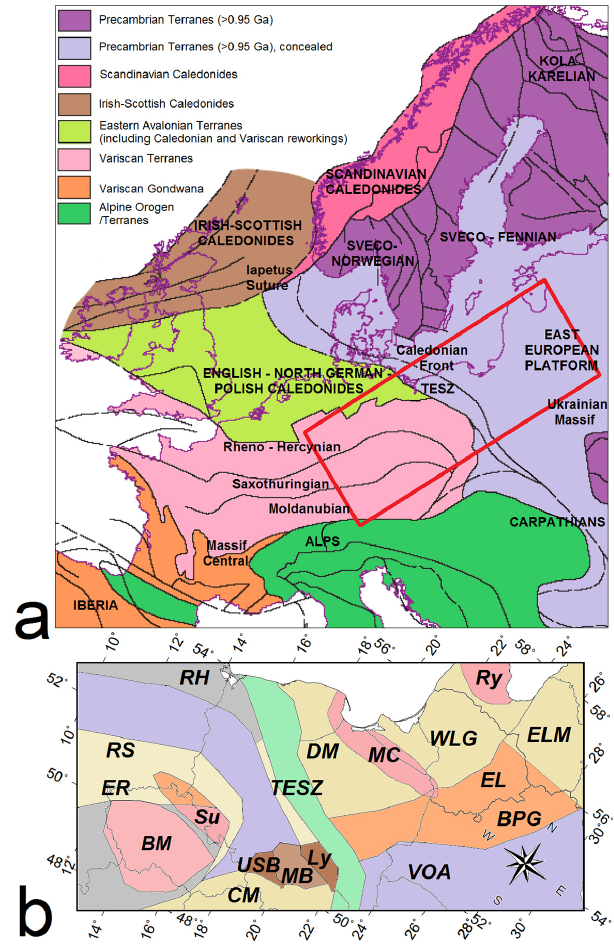
Figure 1. (a) Simplified tectonic sketch of Precambrian and Phanerozoic Europe (after Blundell et al., 1992). Study area indi- cated by red rectangle. (b) Tectonic sketch of the study area com- piled from Skridlaite and Motuza (2001), Malinowski et al. (2008), Guterch et al. (1999), Bogdanova et al. (2001), and Gee and Stephenson (2006). Units: BM, Bohemian Massif; BPG, Belarus– Podlasie Granulite Belt; CM, Carpathian Mountains; DM, Dobrzyn Massif; EL, East Lithuanian Domain; ELM, East Latvian Massif; ER, Eger Rift; Ly, Lysogory; MB, Malopolska Block; MC, Mazury Complex; RH, Rheno-Herzynian Front; RS, Rheic Suture; Ry, Riga batholith; Su, Sudetes Mountains; TESZ, Trans-European Suture Zone; USB, Upper Silesian Coal Basin; VOA, Volyn–Orsha aulaco- gen; WLG, West Lithuanian Granulite